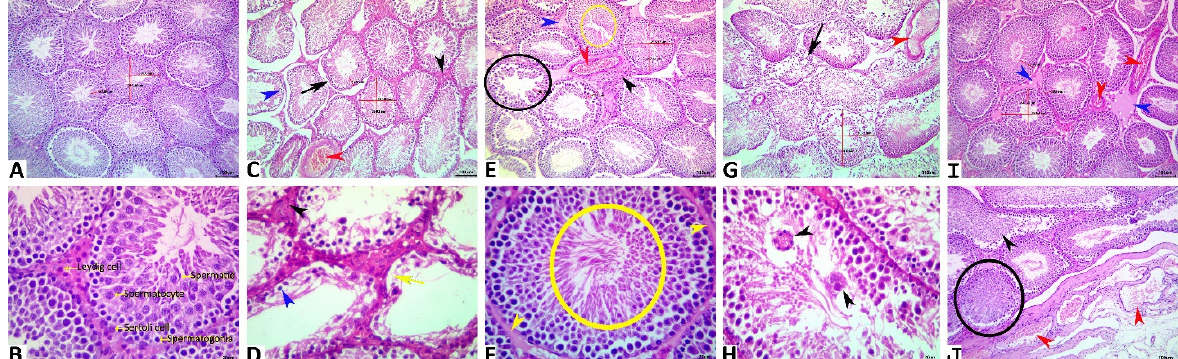
Figure 6. Representative photomicrograph of H&E stained testicular tissue sections showing normal histological picture in the control rats ( A and B ). HFT/STZ testes showing congestion (red arrowhead), vacuolated germinal epithelium (blue arrowhead), necrotic germinal epithelium, (yellow arrow), interstitial fibrosis (black arrowhead), and redundant basal lamina (arrow) ( C and D ). HFT/STZ+MF testes showing germ cell depletion (black ellipse), spermatid retention (yellow ellipse), thickened basal lamina (yellow arrowhead), interstitial edema (blue arrowhead), fibrosis (black arrowhead), and congestion (red arrowhead) ( E and F ). HFT/STZ+CH-SeNPs testes showing congestion (red arrowhead), multinucleated giant cell s (black arrowheads) and redundant basal lamina (arrow) ( G and H ). HFT/STZ+MF+CH-SeNPs testes showing congestions (red arrowheads), desquamated germinal epithelium (black arrowhead), and sperm stasis (ellipse) ( I and J ). Scale bar is 100 microns for A, C, E, G, and I, and 20 microns for B, D, F, H, and J. Table 2. Effect of metformin (500 mg/kg bwt) and/or chitosan-stabilized selenium nanoparticles (2 mg Se/kg bwt) on lesion scoring of testicular tissues of HFD/STZ-diabetic rats. Lesion Control HFD/STZ HFD/STZ+MF HFD/STZ+CH-SeNPs HFD/STZ+MF+CH-SeNps Spermatogonial cells/ST 66.90 a ± 1.16